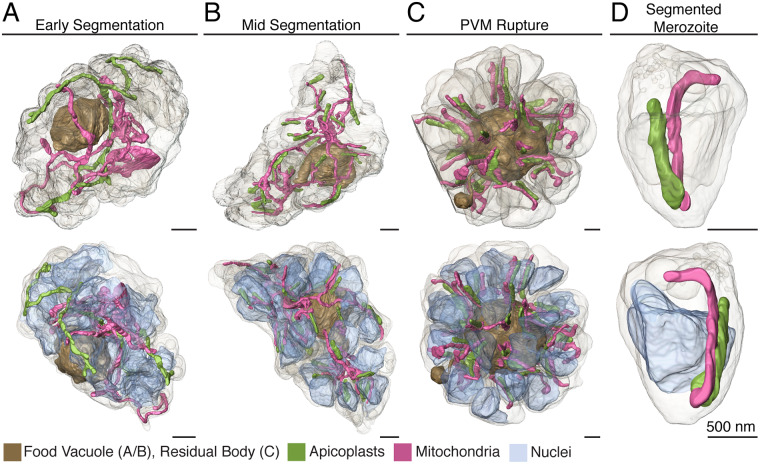
Apicoplast and mitochondria morphology throughout segmentation.A. In early segmentation, the apicoplast and mitochondrion each form a sinuous structure throughout the parasite. B. By mid-segmentation, apicoplasts have divided to form one organelle for each nascent daughter cell and are closely associated with the mitochondrion, which remains undivided. C. At PVM rupture, both apicoplasts and mitochondria are divided and are largely situated within segmented daughter cells. D. A segmented merozoite from the schizont in (C), with a single mitochondrion and apicoplast. Scale bars of renderings interpolated from structure sizes in EM data.